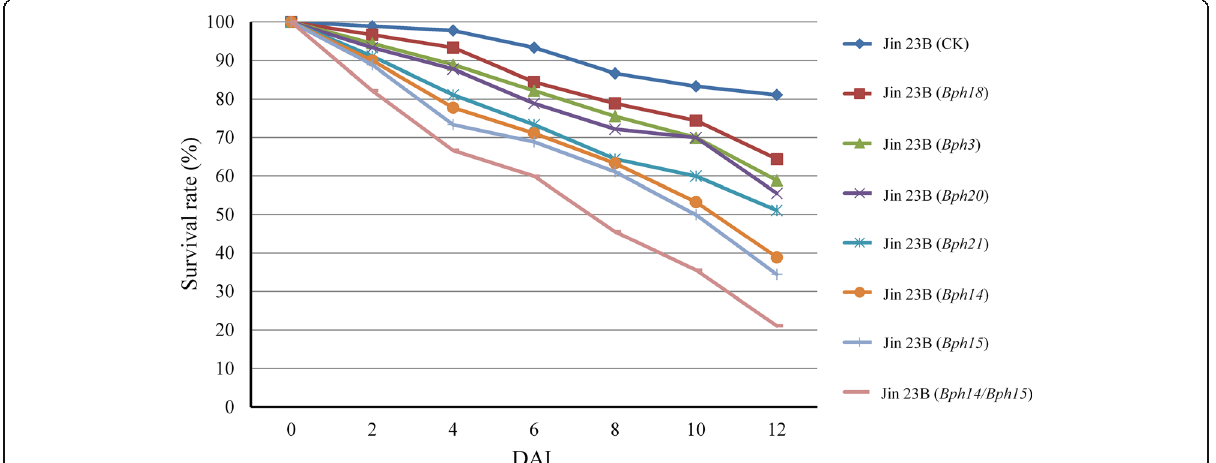
Fig. 6 Survival rates of BPH on Jin 23B pyramiding line and introgression lines. The BPH survival rate was measured in every two days interval for 12 days. DAI: days after infestation